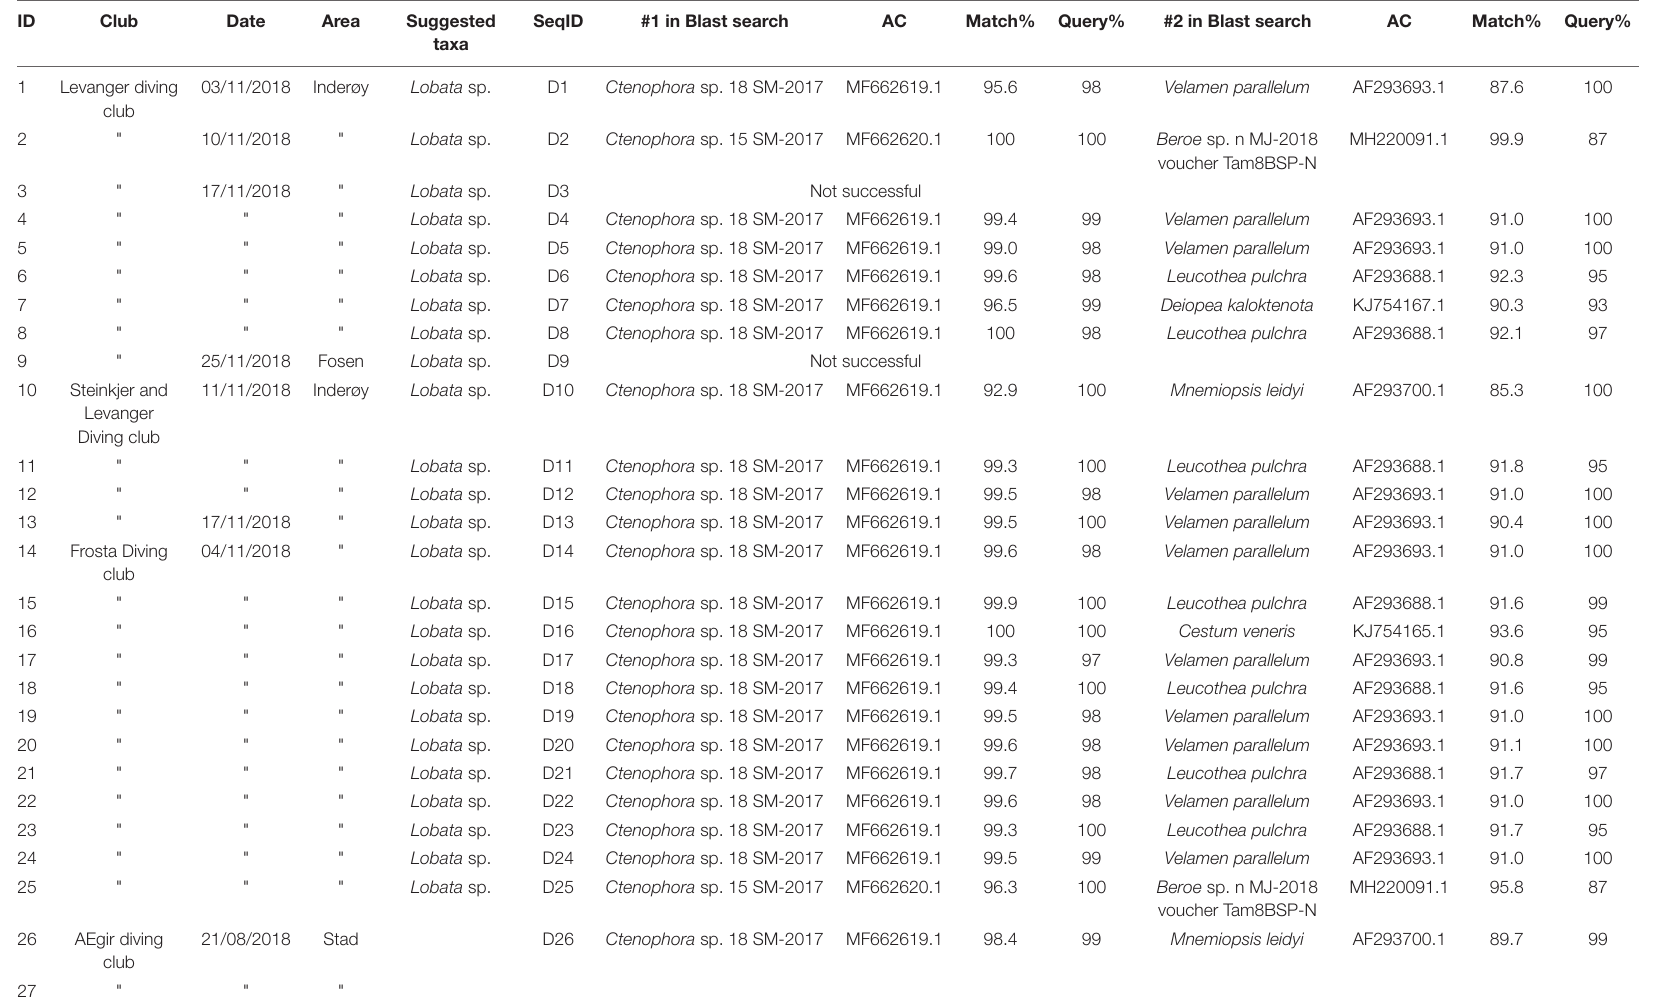
TABLE 1 | Information on the ctenophore samples received from the participating diving clubs together with morphological and molecular species identification. ID